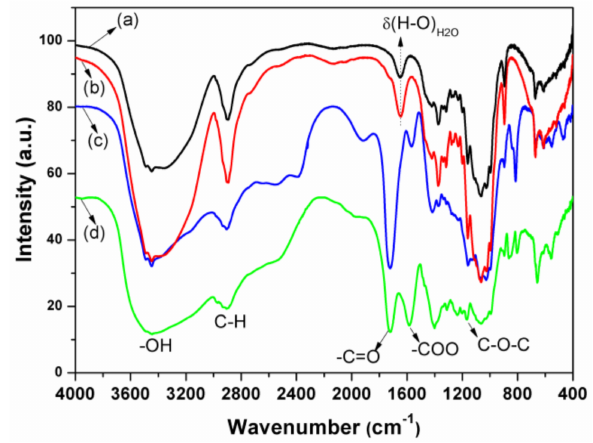
Figure 3. FT-IR spectra of PCNC (a), CNC_TR (b), CNC_TiO 2 (c), and CNC_TiO 2 _TR